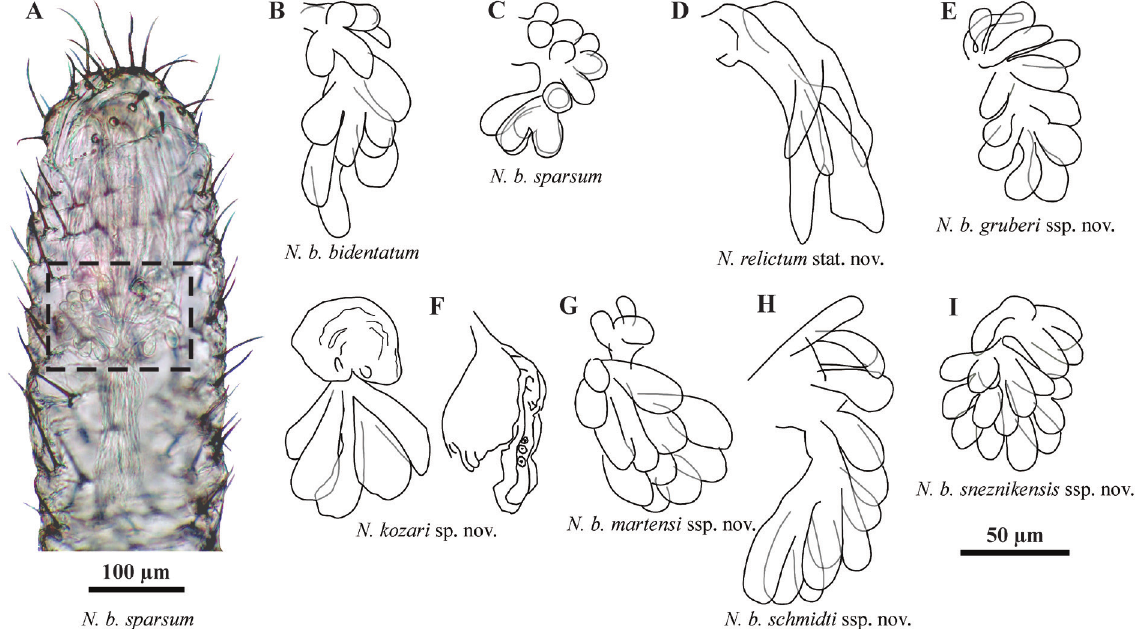
Fig. 11. Nemastoma bidentatum Roewer, 1914 complex, ♀♀; Rec sem (lateral view, right portion, except F left figure, which is in dorsal view). A . The frame encloses the ovipositor portion with Rec sem. Note: Female N. pluridentatum (Hadži, 1973) stat. nov. is